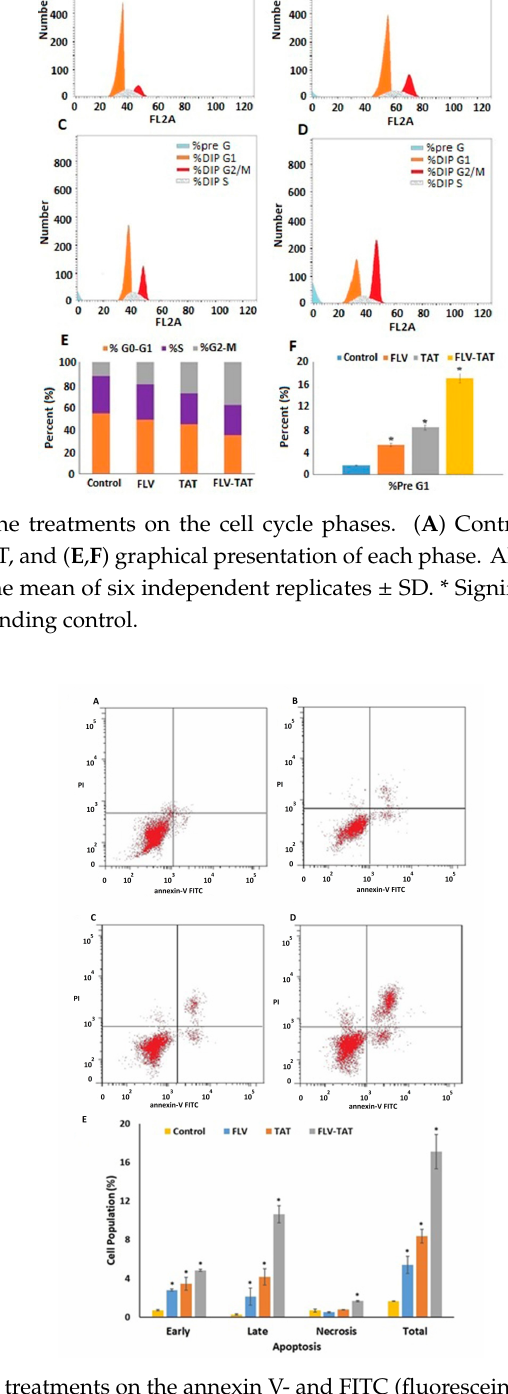
Figure 6. Impact of the treatments on the annexin V- and FITC (fluorescein isothiocyanate)-positive- staining HepG2 cells. ( A ) Control, ( B ) raw FLV, ( C ) TAT, ( D ) optimized FLV–TAT, and ( E ) graphical presentation of early and late apoptotic, necrotic, and total cell death. All incubation continued for 48 h. Data represent mean of six independent replicates ± SD. * Significantly di ff erent ( p < 0.05) relative to the corresponding